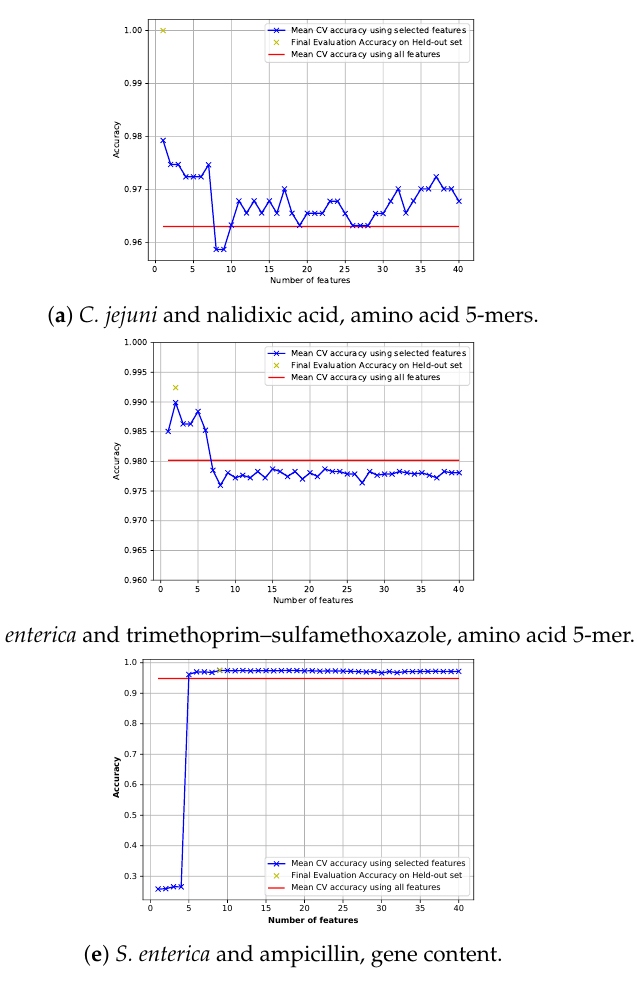
Figure 9. Change in average accuracy of cross-validation when different numbers of features are included in the selected-feature pipeline. ( a ): C. jejuni and nalidixic acid, amino acid 5-mers; ( b ): K. pneumoniae and imipenem, amino acid 5-mers; ( c ): S. enterica and trimethoprim–sulfamethoxazole, amino acid 5-mer; ( d ): S. enterica and trimethoprim–sulfamethoxazole, nucleotide 11-mers; ( e ): S. enterica and ampicillin, gene content; ( f ): S. enterica and amoxicillin clavulanic acid, gene